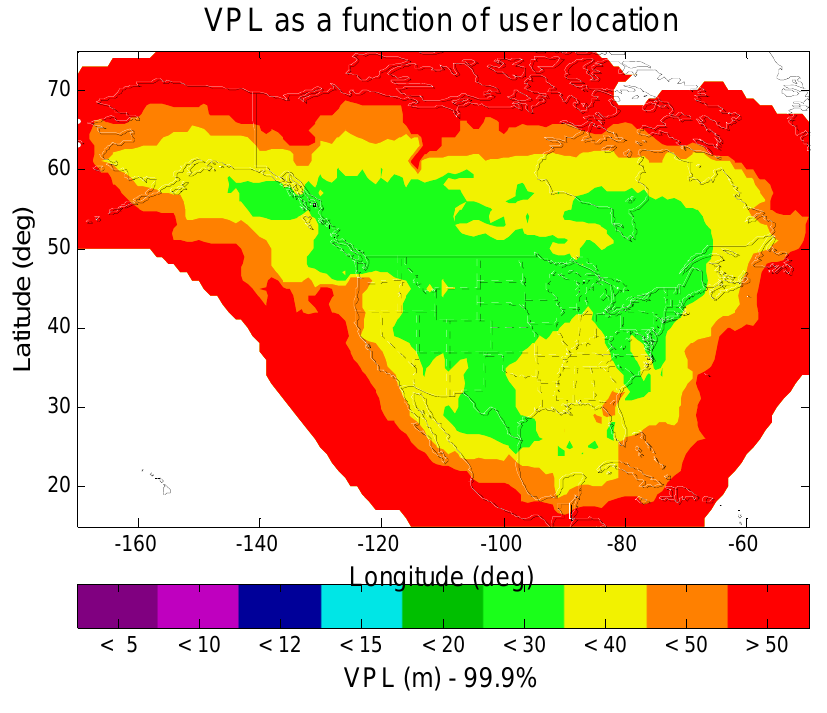
Figure 5. The 99.9% VPL contour of the upgraded WAAS with extended IGP and three GEOs. In comparison with Figure 4, the LPV service coverage in the north region of Canada is slightly